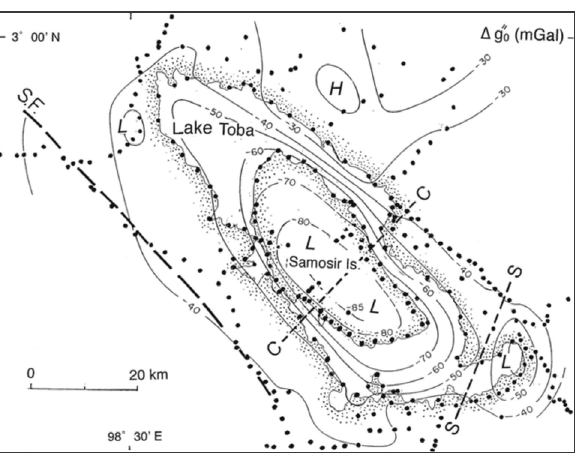
Figure 4. Composite caldera in Lake Toba, Sumatra: distribution of Bouguer gravity anomalies. CC- and SS-lines denote probable boundaries of hypothetical component